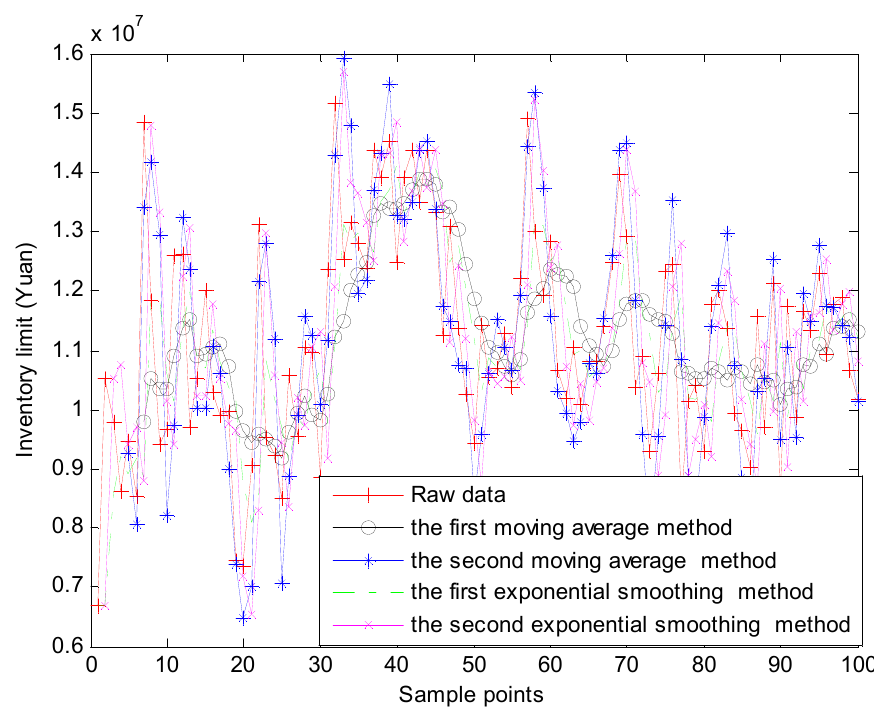
Figure 10. Performance comparison